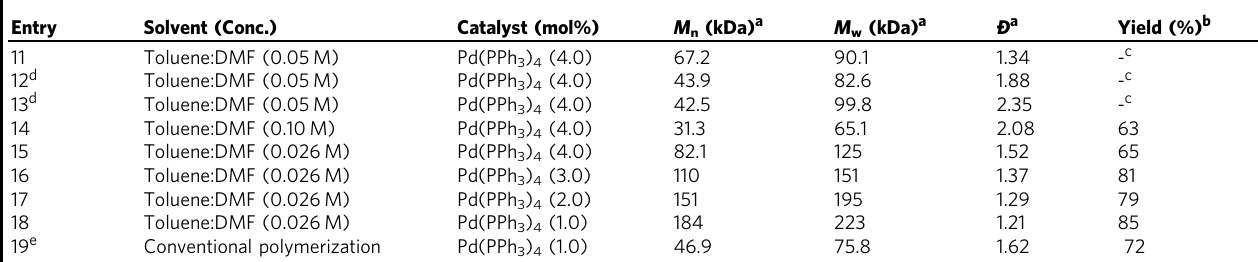
Table 2 Stepwise Stille polymerization with the optimization data